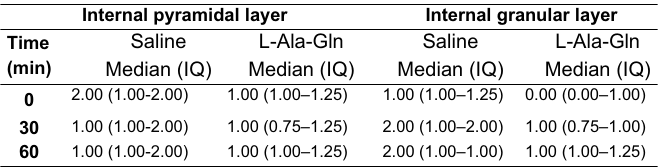
TABLE 5 - Extent of intracellular edema observed upon histological evaluation of the internal pyramidal layer and the internal granular layer of the cerebral cortex for Group S (saline solution) and Group G (L-alanyl-L-glutamine) before (T ) and after 30 minutes (T ) and 60 0 30 minutes (T ) of 60